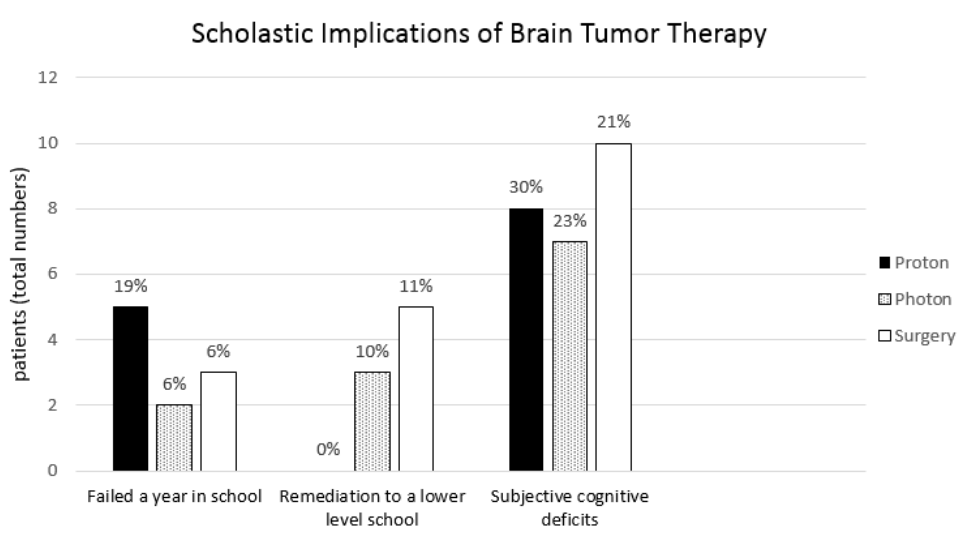
Figure 3. Scholastic implications of brain tumor therapy showing the results of all three therapy groups: proton, photon, and surgery